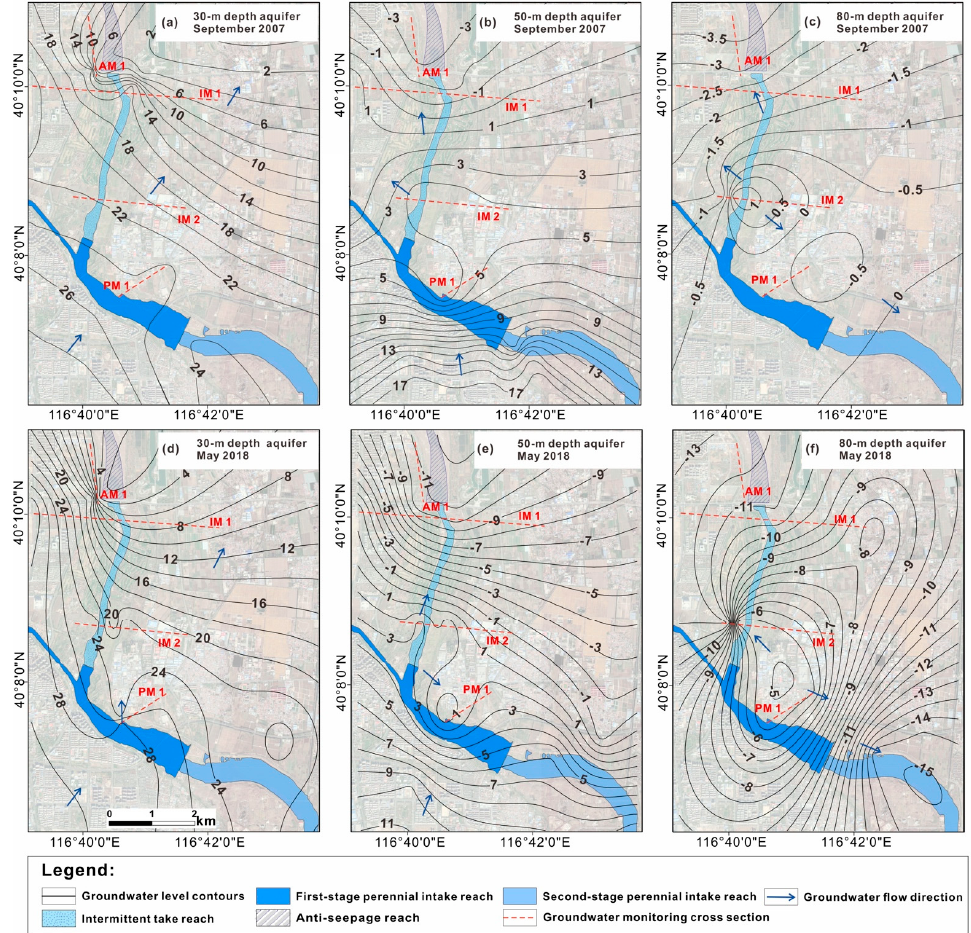
Figure 3. Maps for showing the distribution of groundwater level contours (m) of ( a ) 30-m depth aquifer in September 2007, (b) 50-m depth aquifer in September 2007, ( c ) 80-m depth aquifer in September 2007, ( d ) 30-m depth aquifer in May 2018, ( e ) 50-m depth aquifer in May 2018, and ( f ) 80-m depth aquifer in May 2018. The groundwater levels in September 2007 are referenced from Zheng [15].